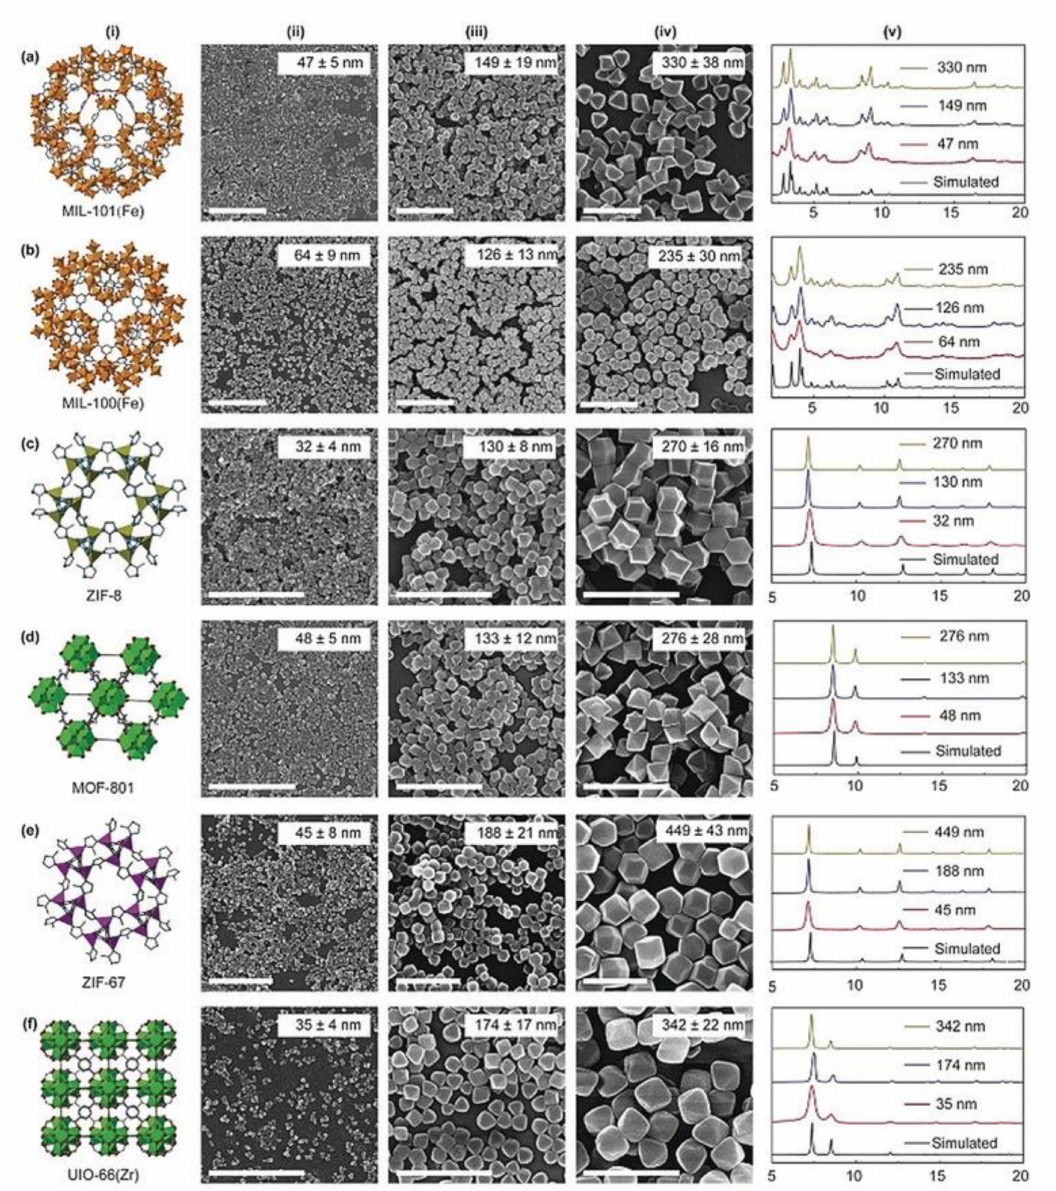
Figure 2. ( i ): ( a ) MIL-101(Fe); ( b ) MIL-100(Fe); ( c ) ZIF-8. ( d ) MOF-801; ( e ) ZIF-67. ( f ) UIO-66-(Zr). ( ii ) – ( iv ) images of representative nanoMOFs of di ff erent sizes. Scale bar: 1 µ m. ( v ) Simulated